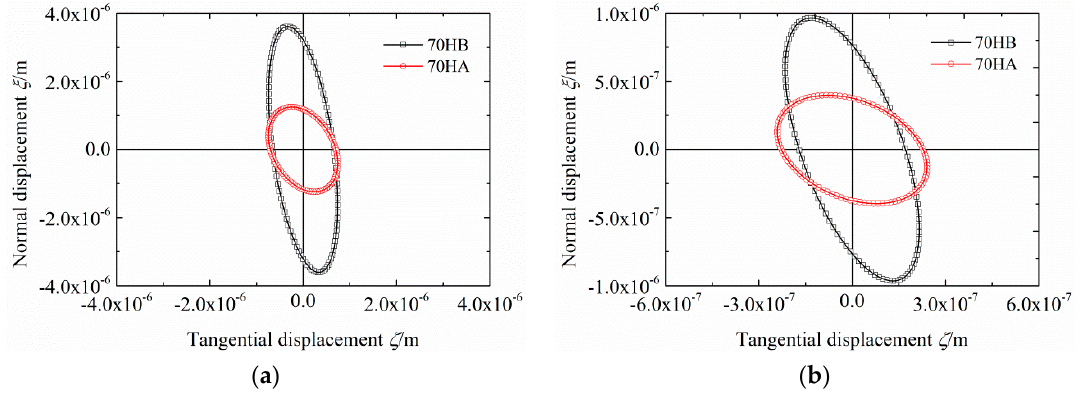
Figure 10. Comparison of stator elliptical motion traces between 70HA and 70HB: ( a ) response without the rotor (preload = 0 N) and ( b ) response with the rotor (preload = 550 N).